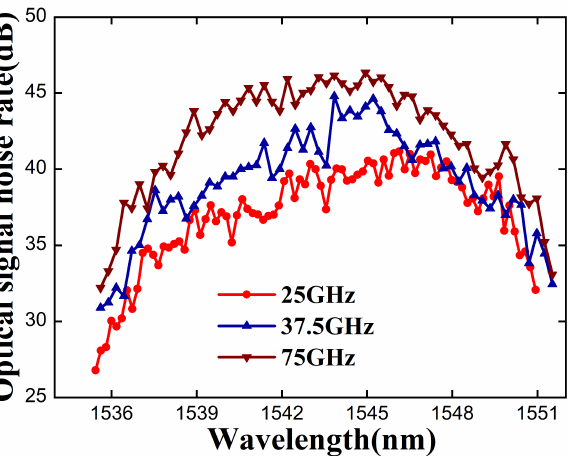
Figure 3. OSNR comparison of the different frequency spacing of OFCs, frequency spacing of 25 GHz (red), 37.5 GHz (blue) and 75 GHz